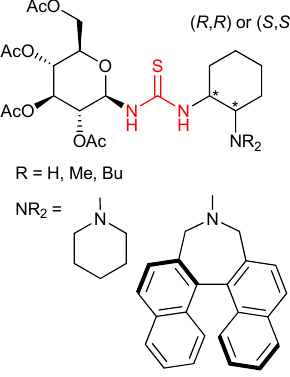
Figure 21. Carbohydrate-derived chiral thiourea [288].